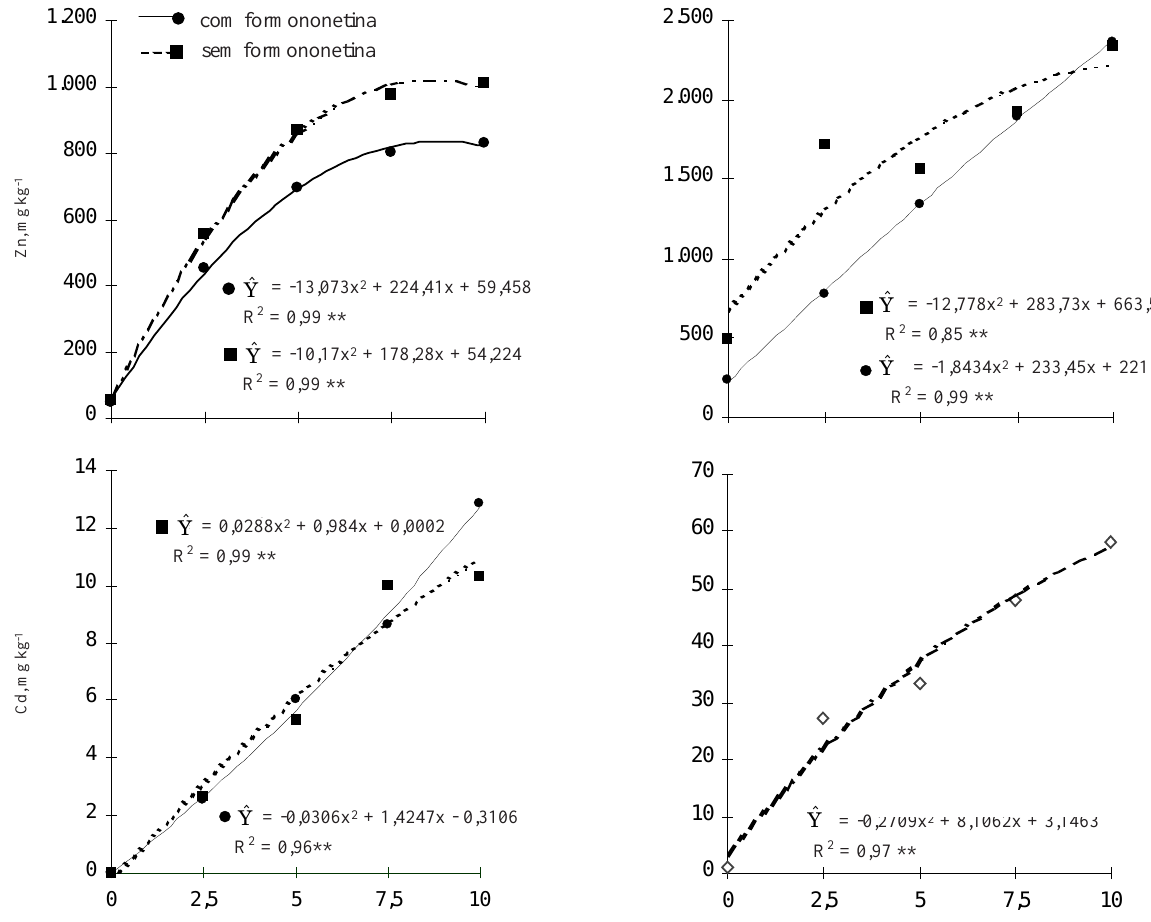
Figura 3. Teores de Zn e Cd na matéria seca da parte aérea das raízes do milho em função da proporção de solo contaminado com metais pesados e aplicação da formononetina.